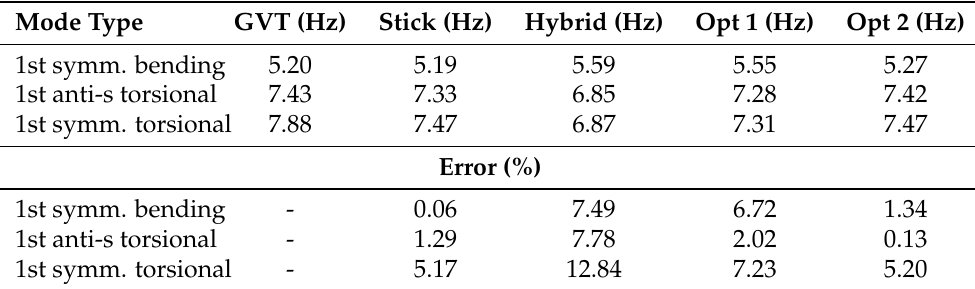
Table 7. Natural frequencies comparison. The presented modes involve mainly wing shapes, with anti-flutter mass in backward position.